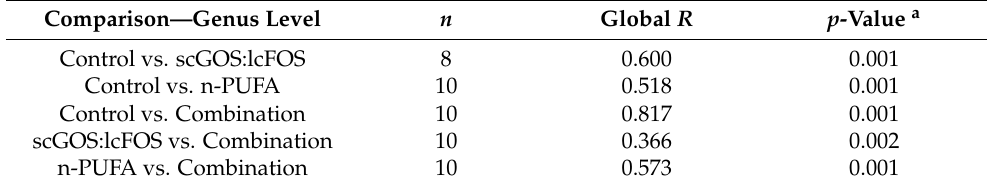
Table 1. Group analysis of similarity (ANOSIM) results for mouse cecum content microbiota